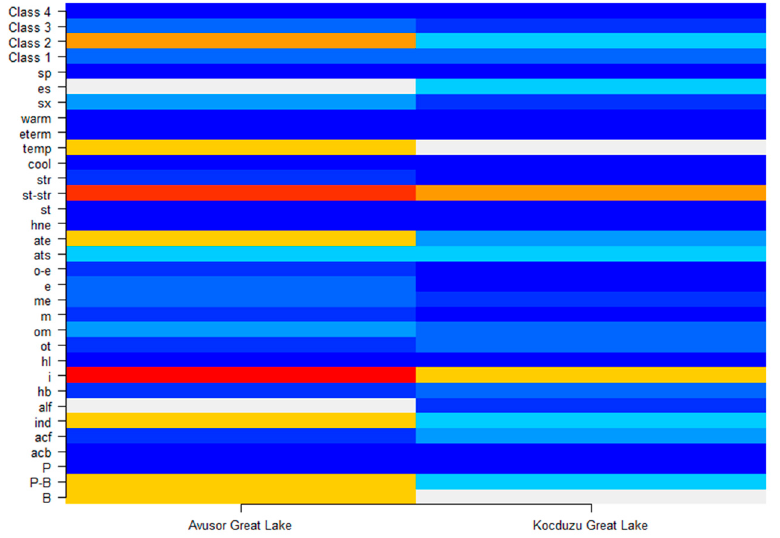
Figure 7. Comparative heat map of indicator species distribution in the ecological groups of the Avusor Great Lake (AGL) and Koçdüzü Great Lake (KGL). The heatmap temperature ranges from 0 (white) to 33 (red). Abbreviations from down to up on axis y: Substrate: B, benthic; P-B, planktonic–benthic; P, planktonic. Water pH: acf, acidophilic species; ind, indifferent; alf, alkaliphilic species; acb, acidobiontes. Water salinity: hb, halophobe; i, oligohalobious-indifferent; hl, oligohalobious-halophilous). Trophic state: ot, oligotrafentic; o-m, oligo-mesotraphentic; m, mesotraphentic; me, meso-eutraphentic; e, eutraphentic; o-e, oligo- to eutraphentic. Nutrition type as Nitrogen uptake metabolism: ats, nitrogen-autotrophic taxa, tolerating very small concentrations of organically bound nitrogen; ate, nitrogen-autotrophic taxa, tolerating elevated concentrations of organically bound nitrogen; hne, facultative nitrogen-heterotrophic taxa, needing periodically elevated concentrations of organically bound nitrogen. Oxygenation: str, streaming well oxygenated waters inhabitant; st-str, low streaming medium oxygenated waters inhabitant; st, standing low oxygenated water inhabitant. Water temperature: cool, cool-loving species; temp, temperate temperature water inhabitants; eterm, eurythermic species, warm, warm water inhabitants. Organic pollution, Watanabe: sx, saproxenes, es, eurysaprobes; sp, saprophiles. Class of water quality based on species–specific index saprobity S: Class 1, S = 0.0–0.5; Class 2, S = 0.5–1.5; Class 3, S = 1.5–2.5; Class 4, S =